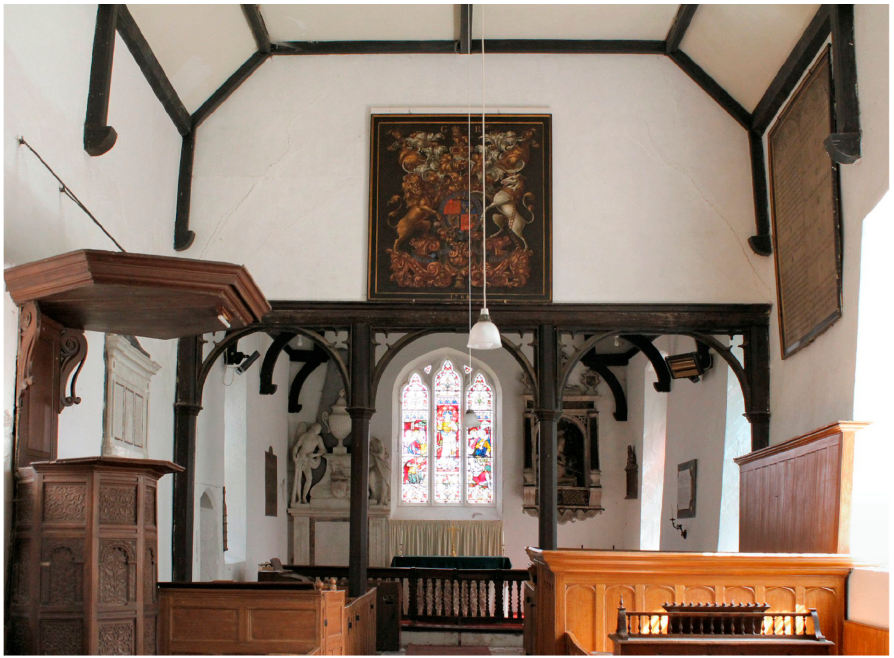
Figure 2. Winkburn church, Nottinghamshire, U.K. Interior of the building showing a 17th century wood and plaster screen between the nave and the chancel.